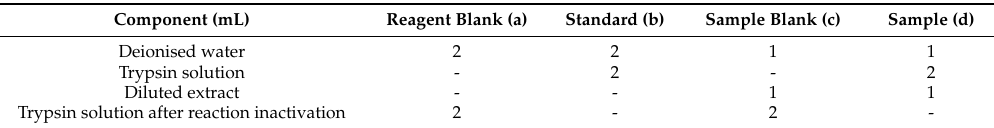
Table 1. Reagent composition in extracted filtrate.